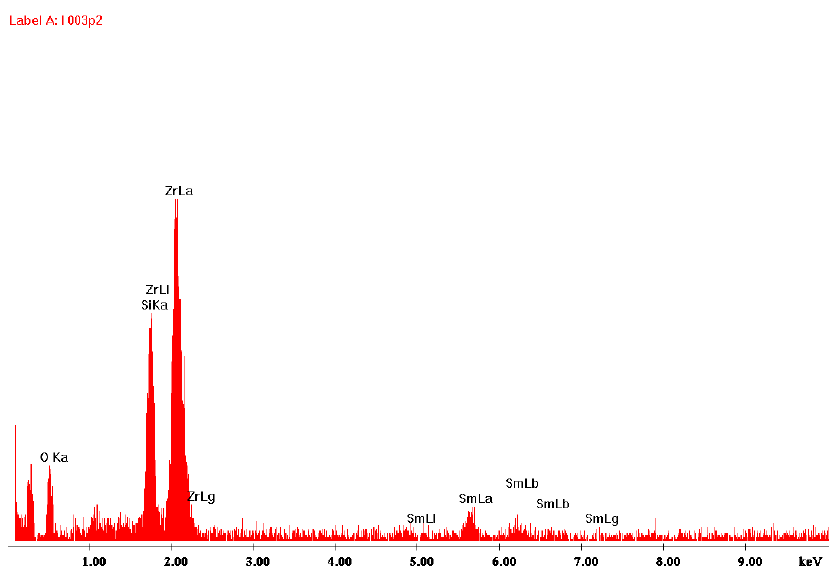
Figure 3. EDS spectrum obtained at point 2 of Figure 1.